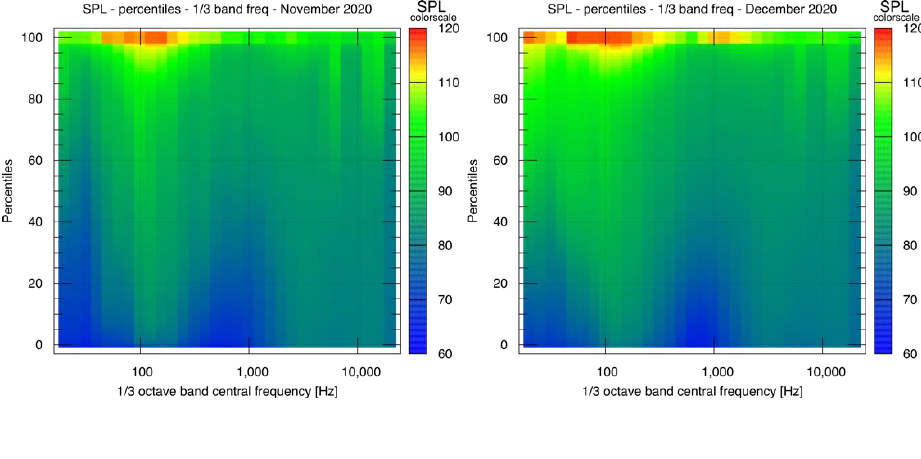
Figure 13. Percentiles versus the one-third octave band central frequency plot of SPL levels in the range between 60 dB and 120 dB.